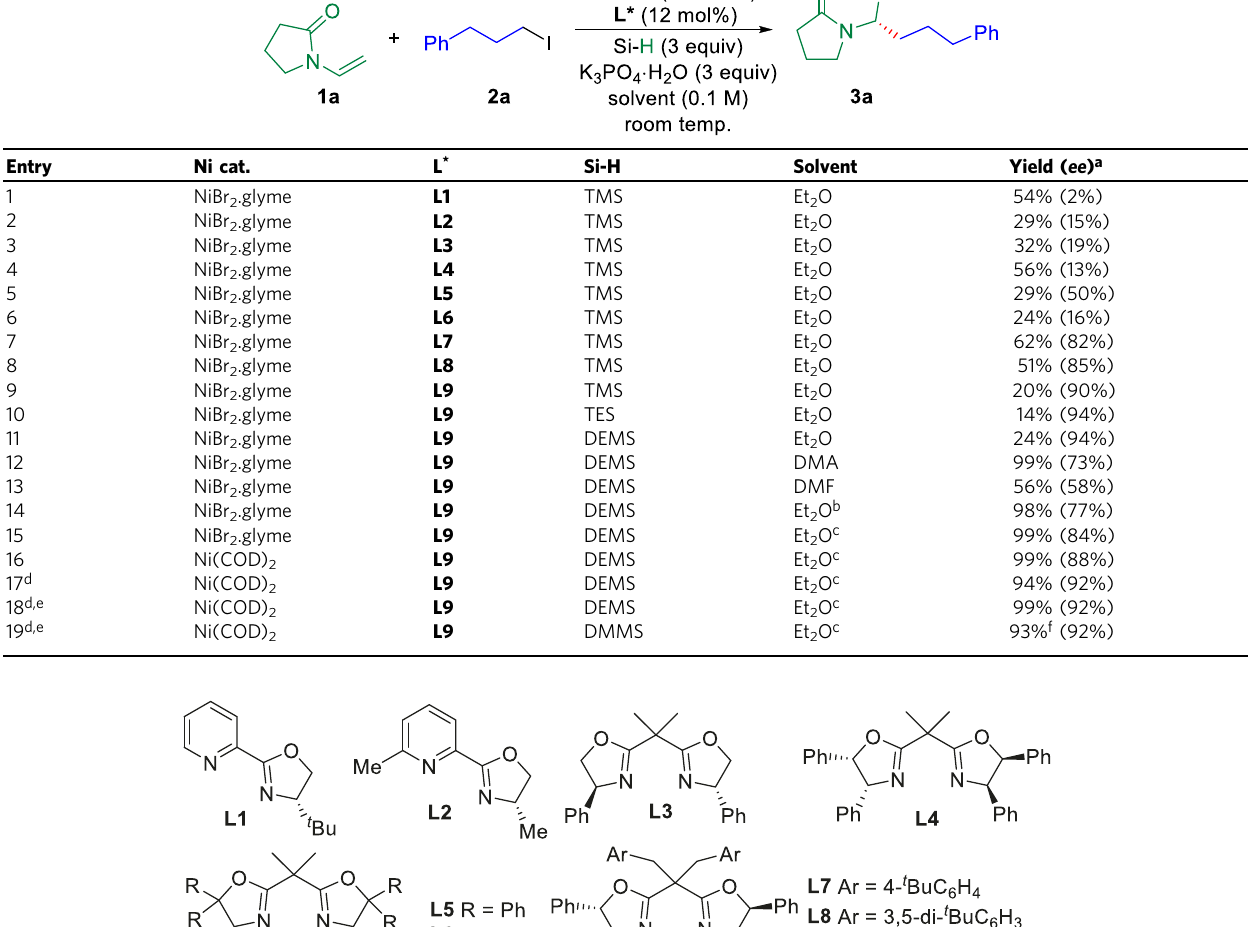
(Table 1, entries 14 and 15). Further optimization of the nickel precursor and reaction temperature improved the yield and enantioselectivity of 3a (Table 1, entries 16 – 18). The use of Ni